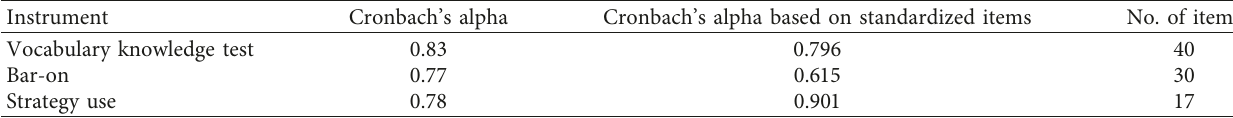
Table 2: Internal consistency index for instruments of the study.